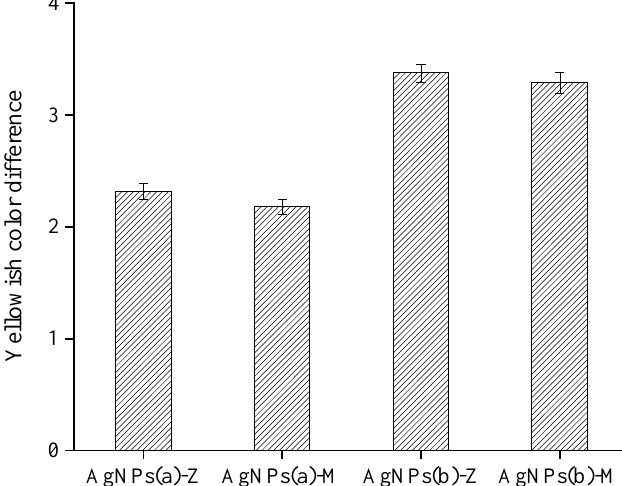
Figure 6. Effects of antimicrobial additives on yellowing color difference of the coatings.